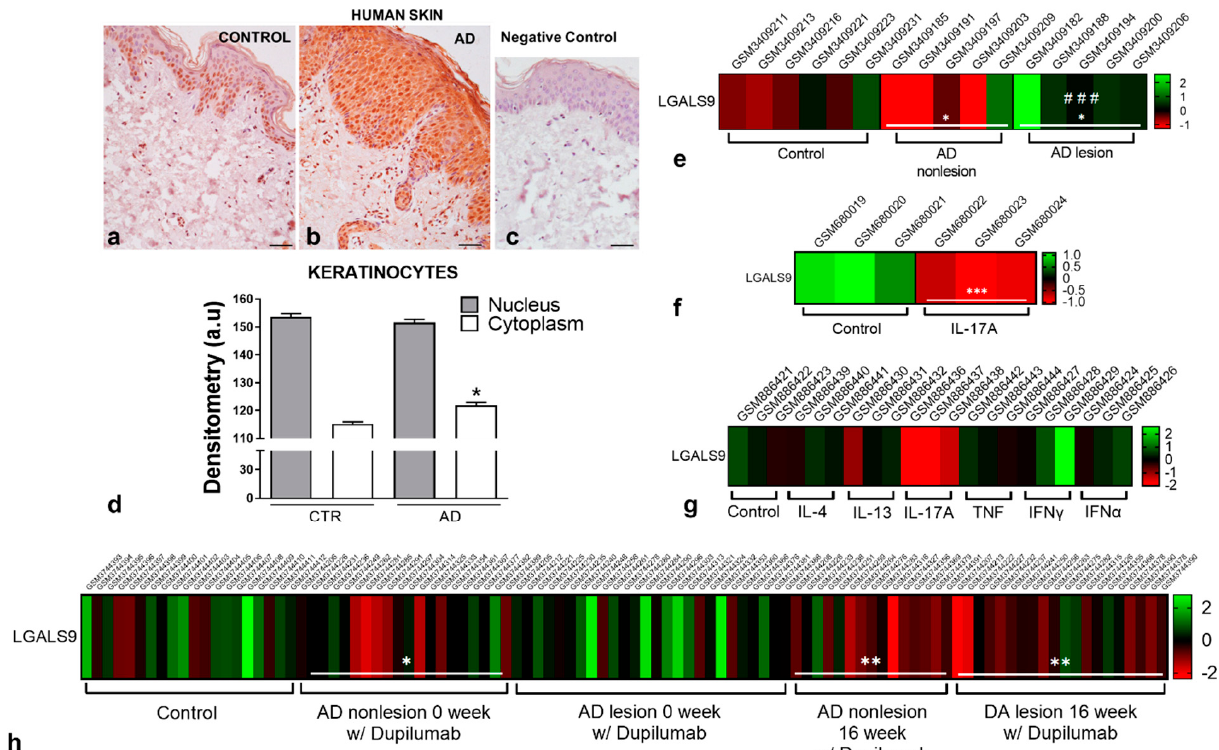
Figure 4. Expression of Gal-9 in the human skin. ( a , b ) Levels of Gal-9 in the human AD and control skins. Epidermis from AD skin samples shows intense immunoreactivity for Gal-9 compared to the control skin. ( c ) Absence of immunoreactivity for Gal-9 in the negative control. Counterstain: hematoxilin. Scale bars: 40 µ m. ( d ) Densitometry for Gal-9 in keratinocytes. Data represent means ± SEM of Gal-9 expression in the nucleus and cytoplasm of cells in a.u. ( n = 9–10 patients/group). * p < 0.05 vs. cytoplasm of control keratinocyte (Kruskal–Wallis, Dunn post-test). ( e – h ) Heatmaps based on the Z-scores of LGALS9 transcriptional levels in the healthy (control) and AD human skins (GSE120721) (e); control/IL-17A-stimulated HaCaT cells (GSE27533) ( f ); control and cytokine (IL-4, IL-13, IL-17A, IFN- γ , IFN- α , and TNF)-stimulated primary keratinocytes (GSE36287) ( g ); and in the control (healthy patients), lesion, and nonlesion skins from AD patients treated weekly with subcutaneous doses of 200 mg of dupilumab for 16 weeks (GSE130588) ( h ). * p < 0.05, ** p < 0.01 vs. control (healthy skins); ### p < 0.001 vs. AD nonlesion (ANOVA, Bonferroni post-test). *** p < 0.001 vs. control HaCaT cells ( t -test, unpaired).